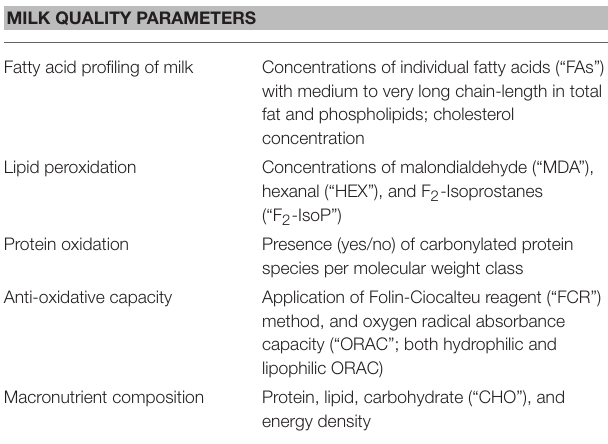
TABLE 1 | Overview of milk